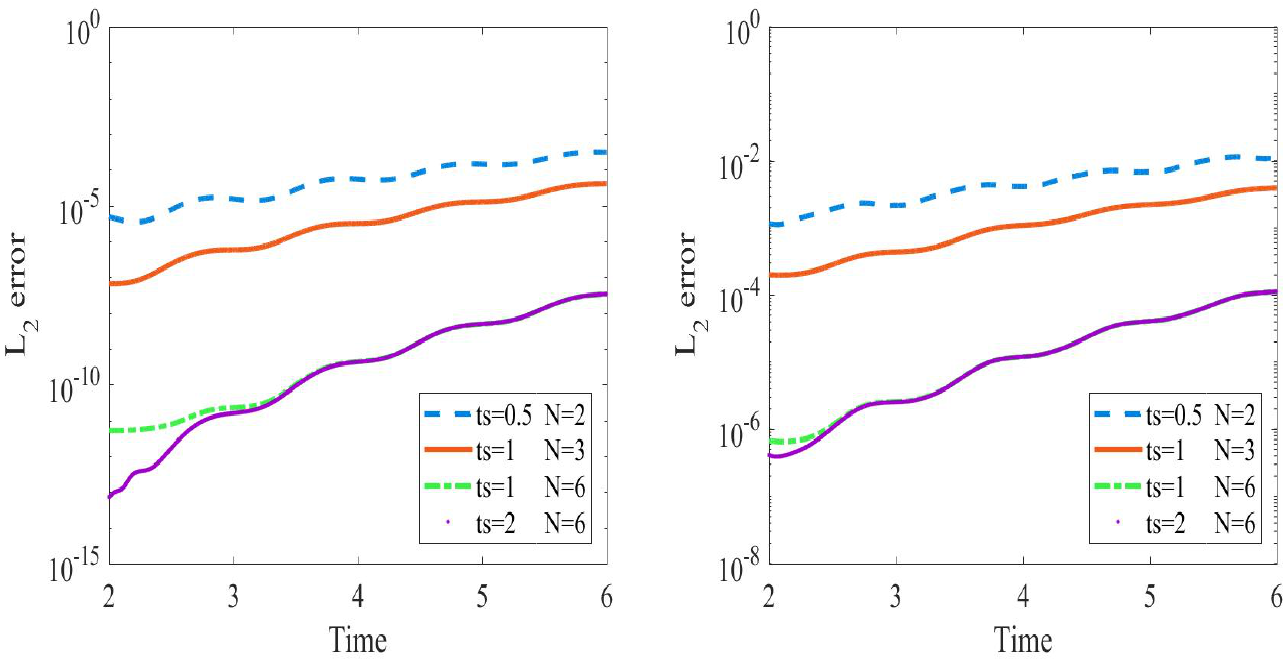
errors at . The switching time with = =